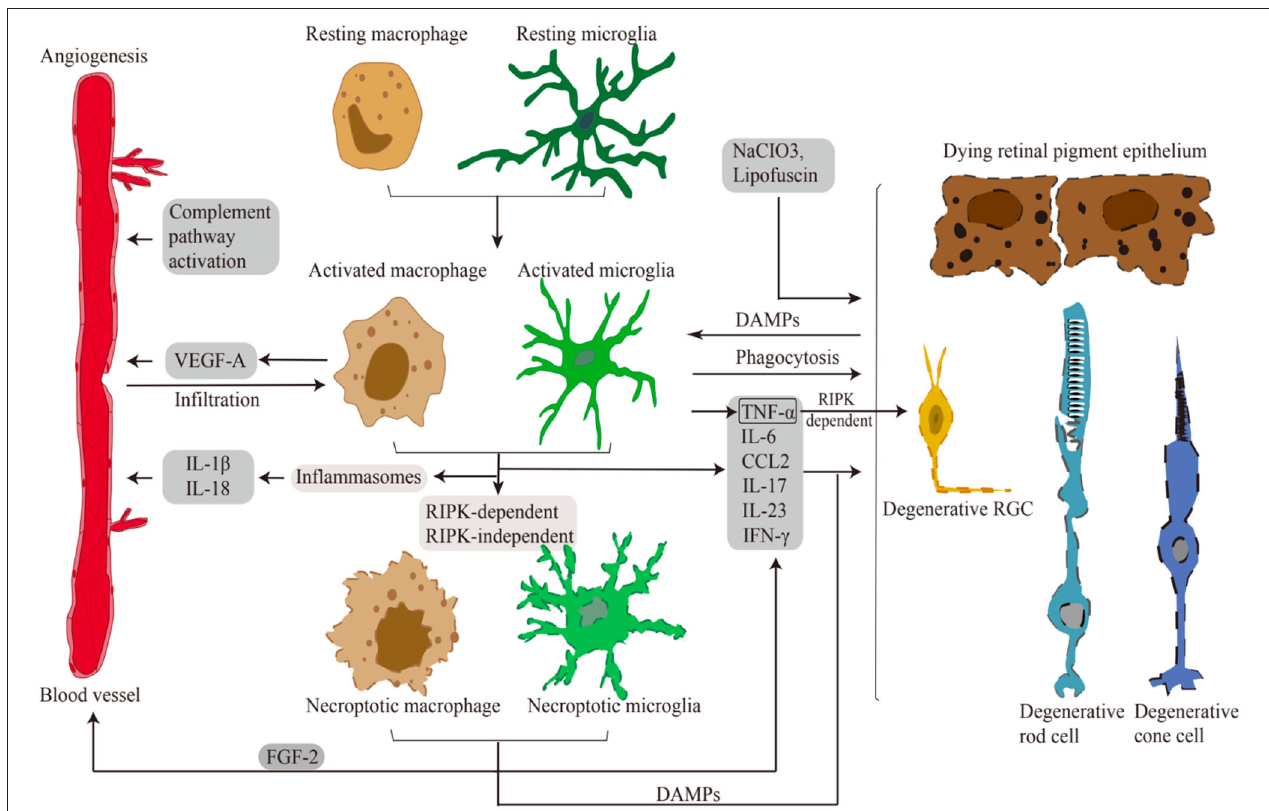
FIGURE 3 | Microglia/Macrophages in retinal disorders. Schematic representation of necroptotic and activated microglia/macrophages in retinal necroptosis and inflammation. Various damages and DAMPs activate innate immune cells. Activated and necroptotic microglia/macrophages via inflammasome-dependent/ -independent mechanisms secrete inflammatory and angiogenic mediators. These pro-inflammatory and angiogenic factors induce choroidal neovascularization. Pro-inflammatory factors and DAMPs also lead to necrotic cell death of RGCs, RPE cells and photoreceptors. Moreover, activated microglia/macrophages infiltrate to the outer retina to phagocytose dead cells and modulate